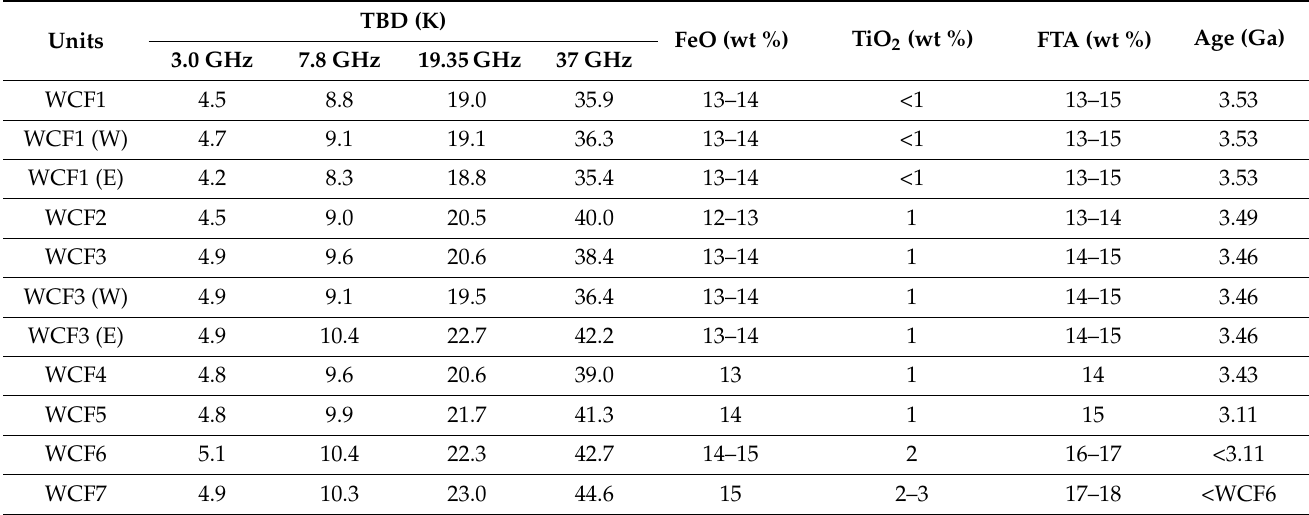
Table 2. The SCREP-based FeO, TiO 2 , and FTA values mapped by Kramer et al. [2] and the